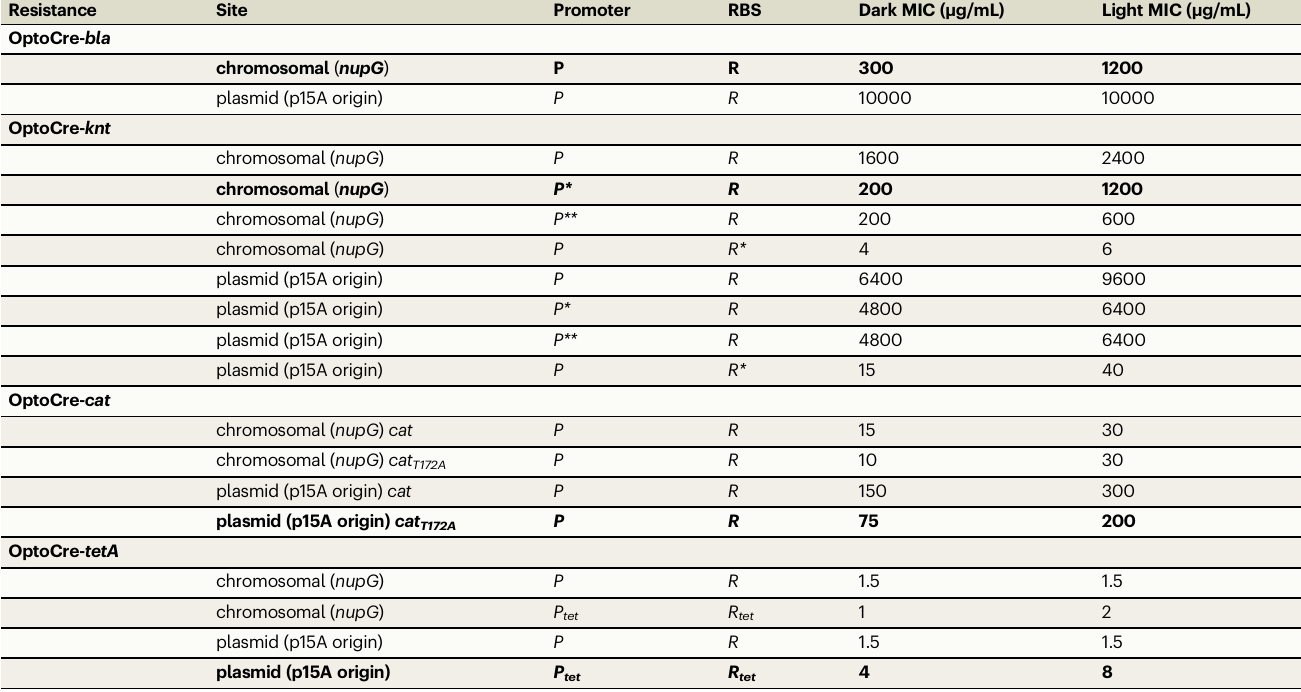
Table 2 | Resistance activation constructs used in this study and respective dark and light state MICs